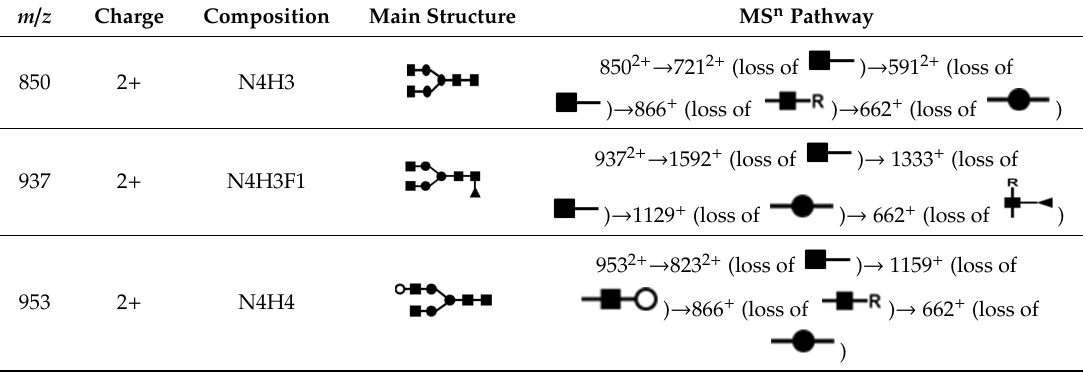
Table 1. Major N-glycans in sera of healthy controls and rheumatoid arthritis patients.